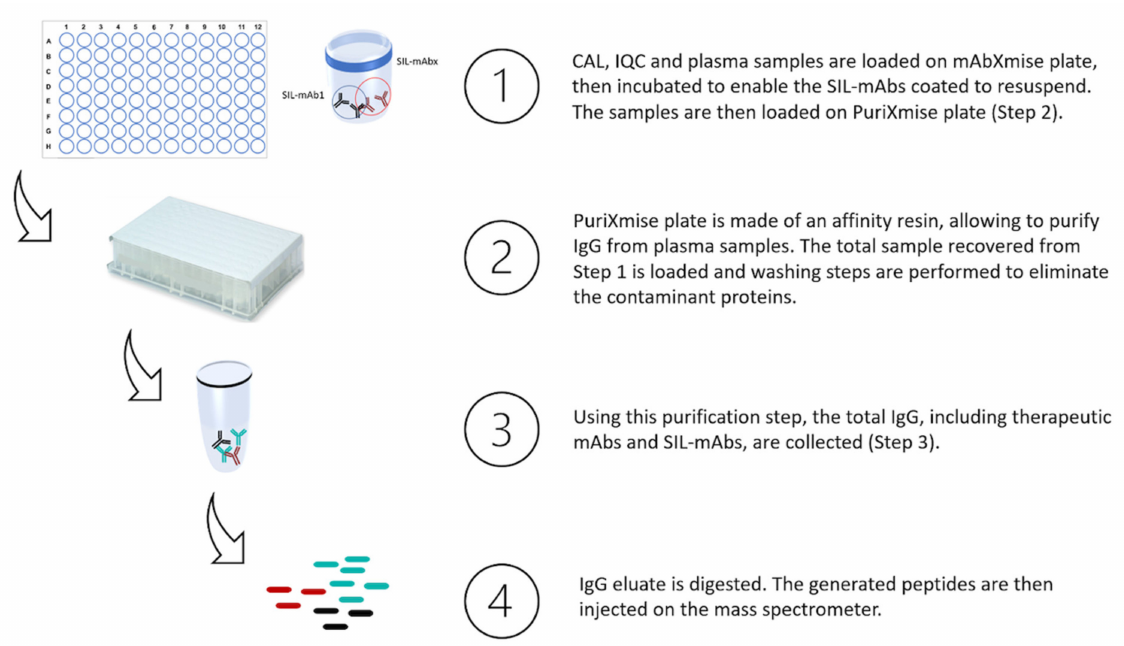
Figure 5. mAbXmise process summarized: collected plasma samples are loaded on mAbXmise plate as well as calibrators and QC samples provided in the kit. Full-length isotopically labelled mAbs, coated on the plate, are resuspended in the plasma samples and will serve as internal quantification standard. Total IgG are purified, recovered, and then digested. At the end of the process, the samples collected are ready to be